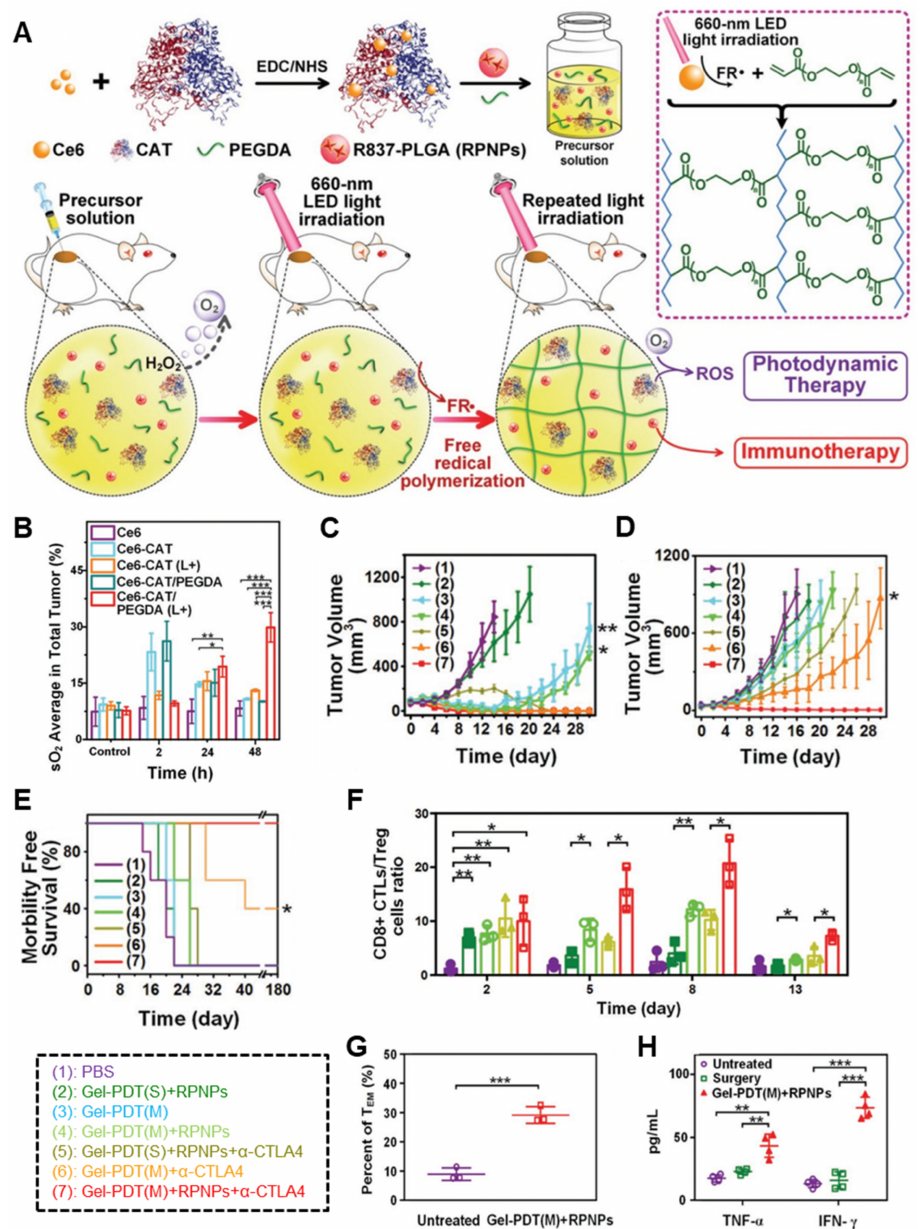
Figure 3. Injectable light-triggered hydrogel with Ce6-CAT and RPNPs for combination photoim- munotherapy. ( A ) Schematic illustration of in situ formation of the light-triggered hydrogel loaded with Ce6-CAT and RPNPs. ( B ) Quantification of levels of the vascular saturated oxygen (sO 2 ) in 4T1 tumors by photoacoustic (PA) imaging. Tumor growth curves of the ( C ) irradiated primary tumors and ( D ) non-irradiated secondary tumors after various treatments, including single (S) or multiiple (M) rounds of PDT. ( E ) Survival after treatment. ( F ) CD8 + CTL to T reg ratios in secondary tumors. ( G ) Effector memory T (T EM ) cell proportion in the spleens. ( H ) Quantification of the amount of TNF- α and IFN- γ in sera after the rechallenge. * p < 0.05, ** p < 0.01, *** p < 0.001, one-way ANOVA for indicated comparison. Figures are reproduced from reference [47], with permission from John Wiley & Sons,